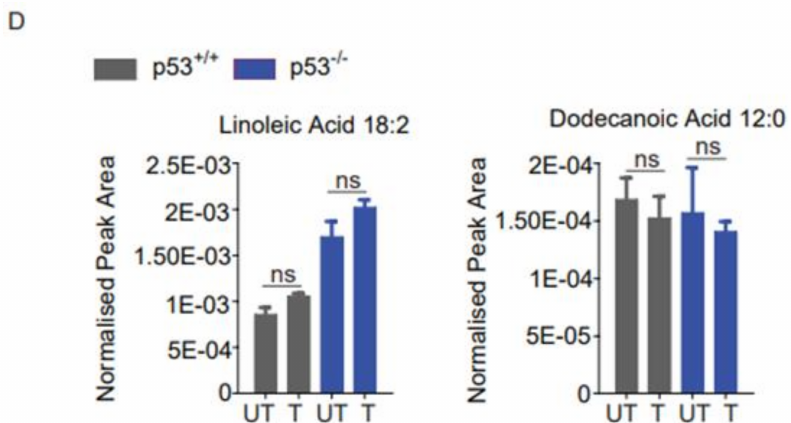
Figure 5. Nitro-deficient niclosamide induces increased lipid metabolite level in p53-deficient cells. ( A ) Hierarchical clustering representation of differential lipid metabolite levels between non-drug treated (UT) and 7.5 µ M ND-Nic treated human colon carcinoma HCT116 p53 +/+ and p53 − / − cells for 16 h. ( B ) Lipid metabolic composition was compared between 7.5 µ M ND-Nic (16 r) denoted as (treated) and untreated (untreated) HCT116 p53 +/+ and p53 − / − cells using principal component analysis scores plot. ( C ) Bar graphs display enriched lipid metabolite levels in 7.5 µ M ND-Nic treated HCT116 p53 − / − cells for 16 h measured by LC-MS including fatty acids (arachidonic acid 20:4, adrenic acid 22:4, eicosapentaenoic acid 20:5, eicosatrienoic acid 20:3, and eicosadienoic acid 20:2) and lysophospholipids (lysophosphatidylethanoamines (LysoPEs): LysoPE 20:3, LysoPE 22:2, and LysoPE 18:1 and lysophoaphatidylcholines (LysoPCs) LysoPC 14:0, LysoPC 26:1, and LysoPC 16:1). Error bars represent ± SD of at least 3 independent experiments. t -test was used to determine significance (*, p < 0.05; **, p < 0.01; ***, p < 0.001; ****, p < 0.0001; ns, p > 0.05). ( D ) Examples of other lipid metabolites unaffected by ND-Nic treatment are shown. Bar graphs display levels of linoleic acid 18:2 and dodecanoic acid 12:0 in 7.5 µ M ND-Nic treated HCT116 p53 − / − cells for 16 h. Error bars represent ± SD of at least 3 independent experiments. t -test was used to determine significance (ns, p >